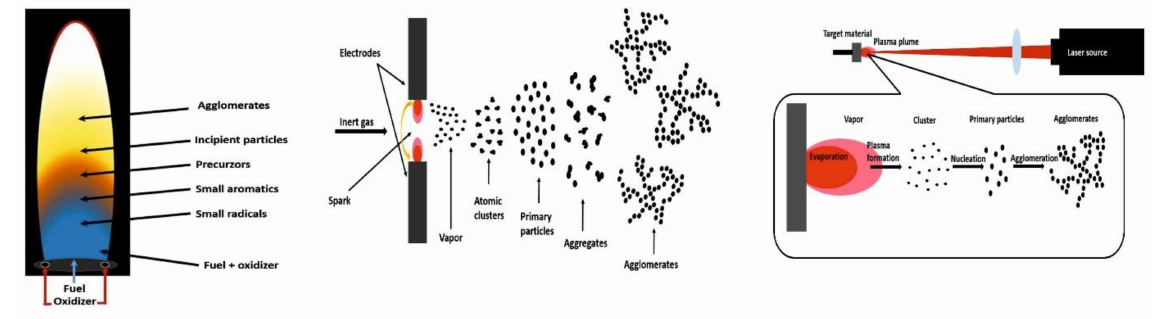
Figure 2. The soot tendency under different excitations mechanism: flame ( left ), spark discharge ( center ), laser ablation ( right